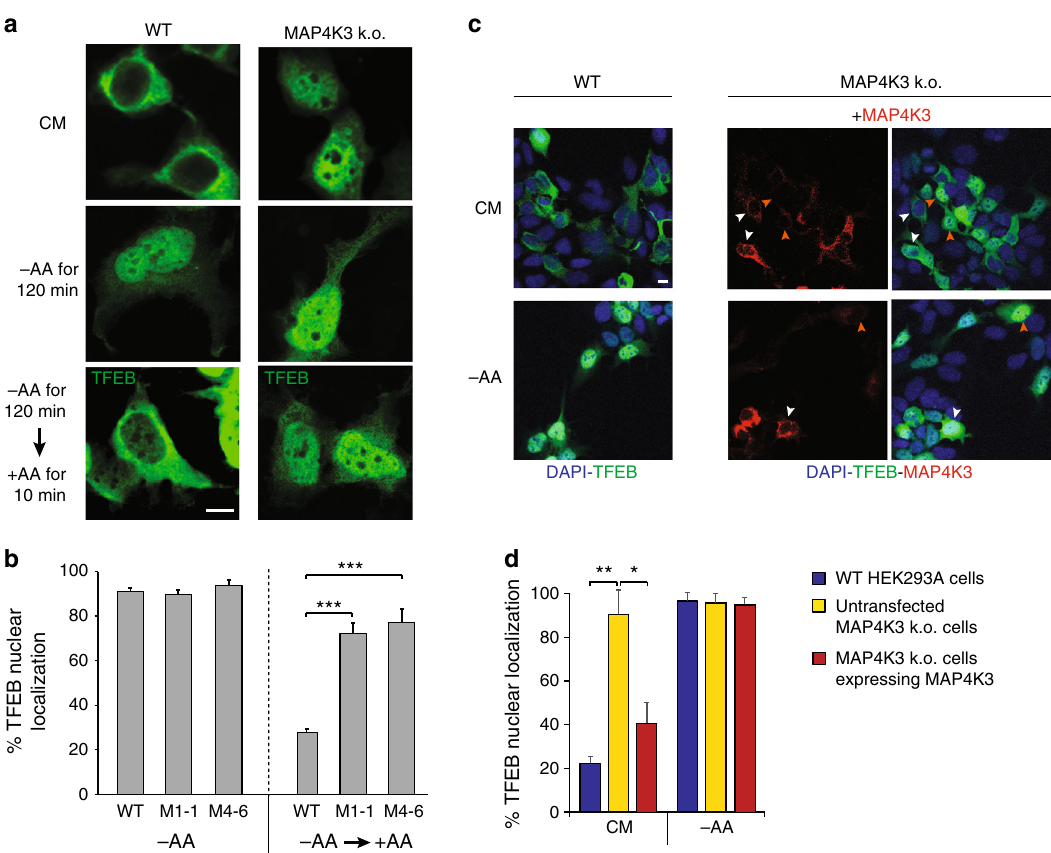
Fig. 2 MAP4K3 regulates TFEB subcellular localization. a Knockout of MAP4K3 yields TFEB nuclear localization. WT HEK293A cells and MAP4K3 k.o. cells were transfected with a TFEB-FLAG expression construct and cultured in complete media (CM) or starved of amino acids for 120 min, and then restimulated with amino acids for 10 min. Here we see representative images of cells immunostained with anti-FLAG antibody. b Quanti fi cation of cells with predominantly TFEB nuclear localization from experiment shown in a . n > 100 cells per condition. One-way ANOVA with post-hoc Tukey ’ s test; *** P < 0.001. c TFEB nuclear localization in MAP4K3 k.o. cells is rescued by MAP4K3 expression. WT HEK293A cells and MAP4K3 k.o. cells were transfected with a TFEB-FLAG expression construct and cultured in CM or amino-acid starved, and MAP4K3 k.o. cells were co-transfected with a MAP4K3-mCherry expression construct. Cells were stained with DAPI and immunostained with anti-FLAG antibody to permit visualization of nuclei, TFEB, and MAP4K3, as indicated. TFEB remains in the cytosol in CM in WT HEK293A cells and in MAP4K3 k.o. cells transfected with the MAP4K3 vector (white arrows); however, TFEB exhibits nuclear localization in untransfected MAP4K3 k.o. cells (orange arrows). Under conditions of amino acid starvation, TFEB translocates to the nucleus in WT cells, MAP4K3-transfected MAP4K3 k.o. cells (white arrow), and untransfected MAP4K3 k.o. cells (orange arrow). d Quanti fi cation of cells with predominantly TFEB nuclear localization from experiment shown in c . n > 50 cells per condition. One-way ANOVA with